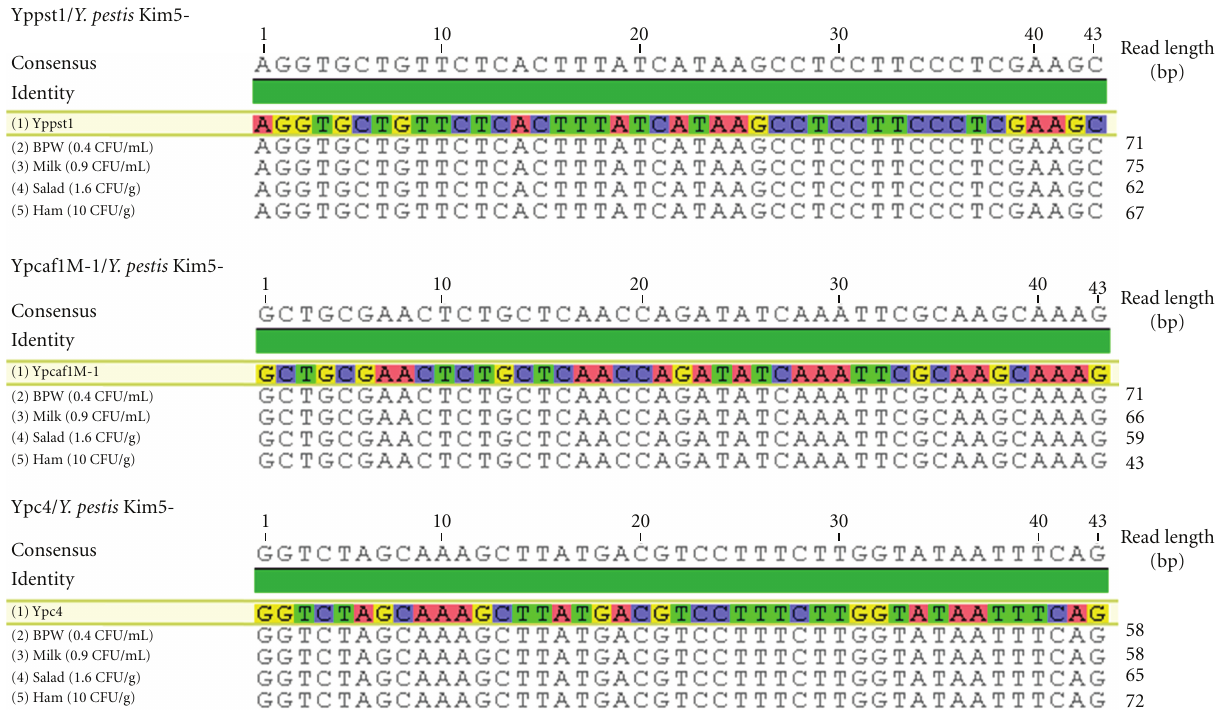
Figure 2: Pyrosequence alignments from Y. pestis isolated from food samples. Pyrosequencing reads for Y. pestis targets including Ypc4 (chromosome), Yppst1 (pPCP1 plasmid), and Ypcaf1M-1 (pMT1 plasmid) are shown with limit of detection from milk, ham, and salad samples.